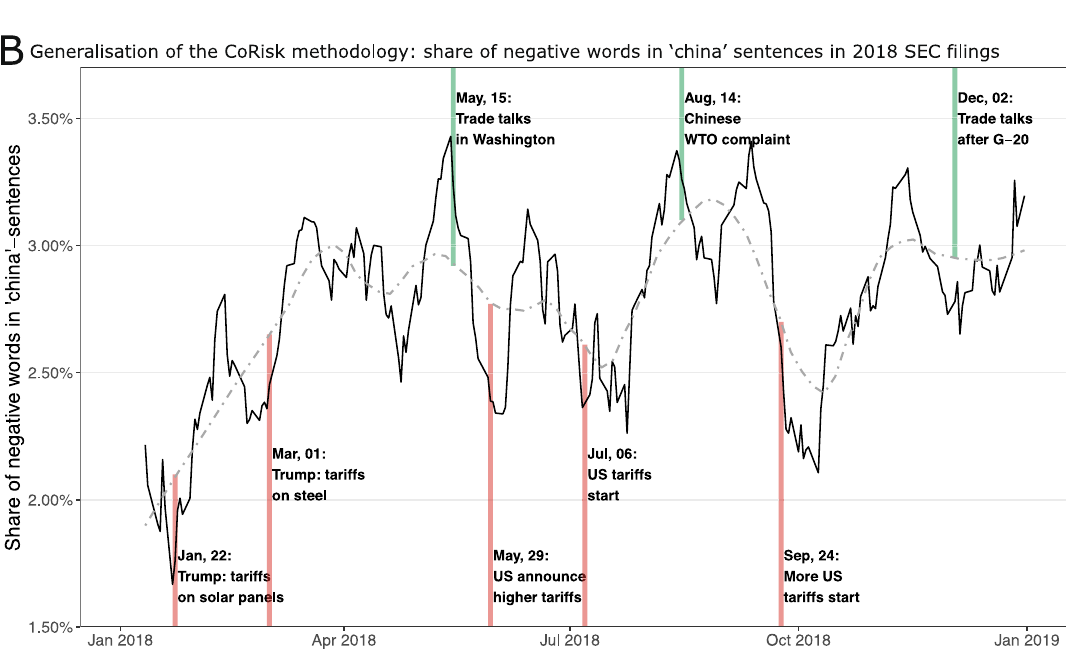
Fig. 3 The CoRisk data re fl ect macroeconomic developments. A Results of Granger causality tests assessing the correlation between the CoRisk-Index and VIX, S&P 1200 Global Index and monthly unemployment rates. We fi nd that the marginals of all-time series are stationarity based on a KPSS test. The Granger causality tests (detailed statistics and the monthly aggregated data used in the tests in Tables 1 and 2) yield signi fi cant results between the CoRisk-Index and unemployment as well as VIX and S&P 1200. This means that values of the CoRisk-Index are correlated with unemployment values, VIX and S&P 1200 during the course of the pandemic. B Generalisability of the CoRisk methodology: share of negative words in ‘ China ’ sentences in 10-K reports during the ‘ US-China trade war ’ in 2018 (solid line and grey dotted trend line). The methodology allows to extract the china-related negative sentiment from the reports and it re fl ects negative (red) and positive (green) events during the crisis, pointing towards the general applicability of the tool to reveal granular insights about the effects of events on